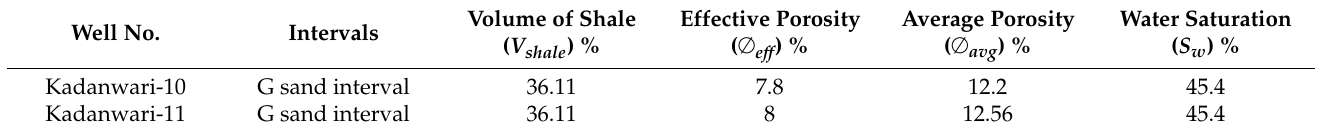
Table 4. Petrophysical properties of the Cretaceous E sand interval in the Kadanwari-10 and Kadanwari-11 Table 3. Petrophysical properties of the Cretaceous G sand interval in the Kadanwari-10 and Kadanwari-11 wells.